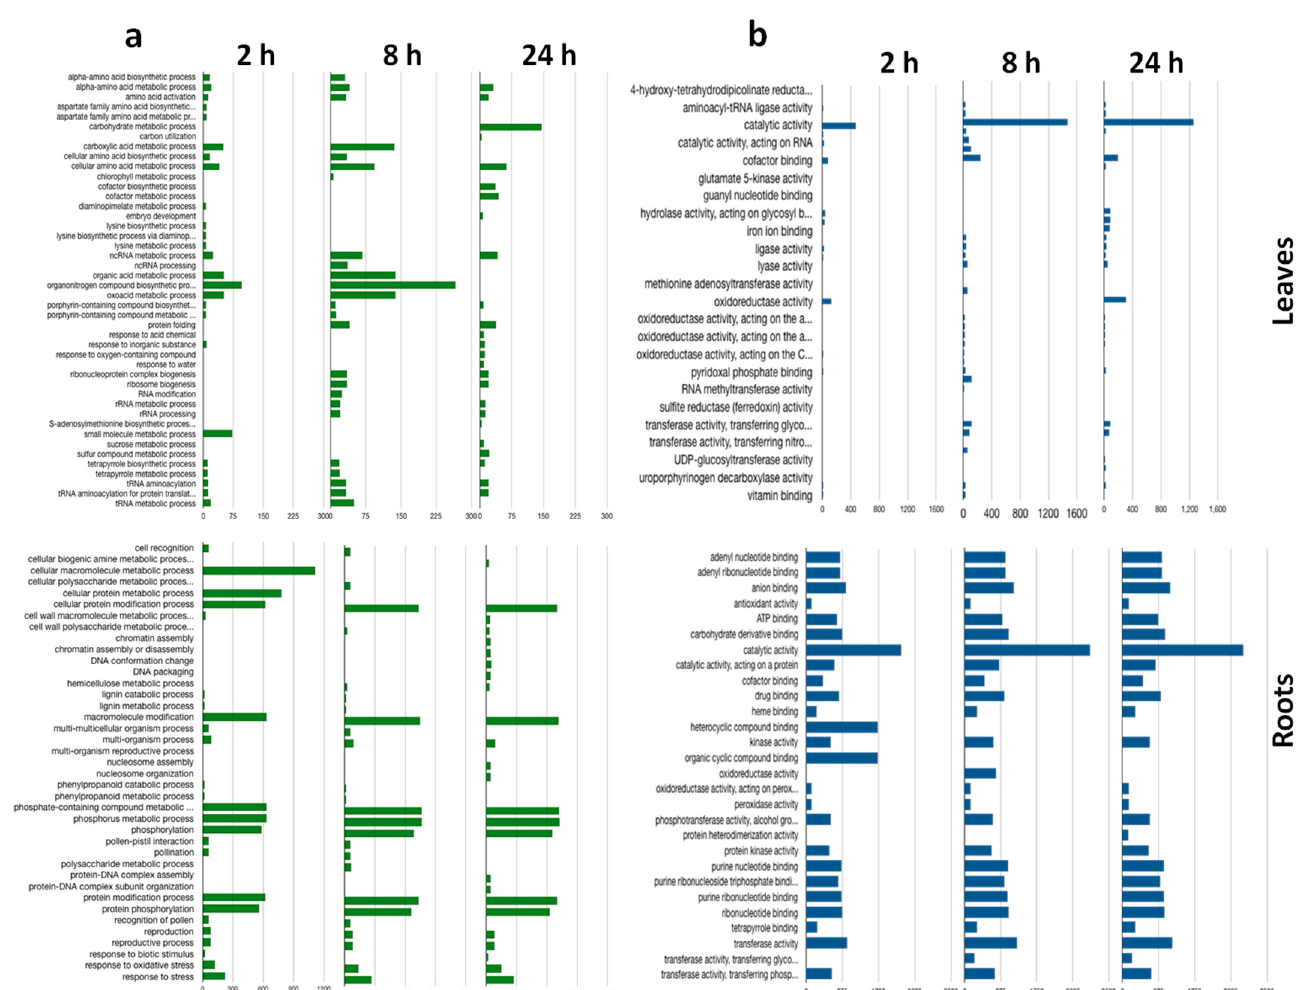
Figure 4. Gene ontology analysis. The gene ontology analysis of biological processes ( a ) and molecular functions ( b ) for the functional groups most significantly enriched among the differentially expressed genes (DEGs) under 2, 8, and 24 h salt stress in both leaf and root tissues. Gene ontology term categories are indicated on the Y -axis. Green ( a ) and blue ( b ) histograms indicate numbers ( X -axis) of DEGs enriched in each category.